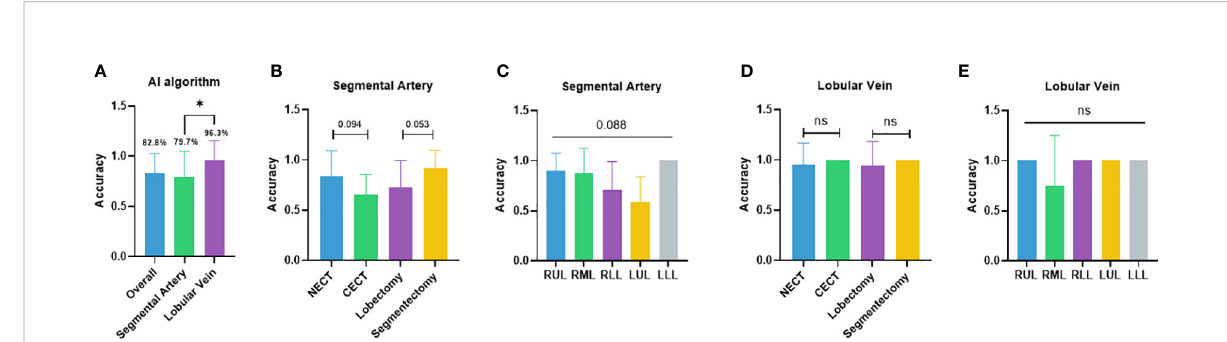
FIGURE 2 Performance of the semiautomated surgical planning algorithm. (A) Case-wise overall accuracy and accuracy in arteries and veins; (B) artery accuracy comparison between contrast and non-contrast CT, lobectomy and segmentectomy; (C) artery accuracy comparison between different lobes; (D) vein accuracy comparison between contrast and non-contrast CT, lobectomy, and segmentectomy; (E) vein accuracy comparison between different lobes. NECT, non-enhanced CT; CECT, contrast-enhanced CT; RUL, right-upper lobe; RML, right-middle lobe; RLL, right-lower lobe; LUL, left-upper lobe; LLL, left- lower lobe. *p<0.05; ns non-signi fi